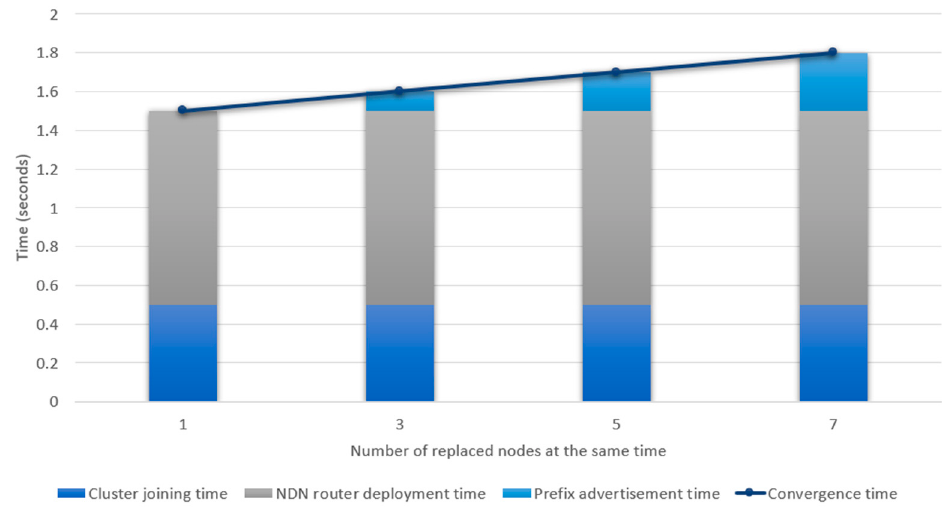
Figure 13. Our system network convergence time.